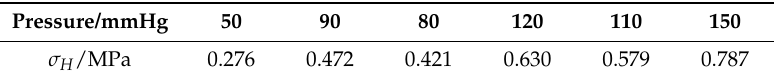
Table 1. (cid:2026) (cid:3009) of PET graft under each inner pressure. Table 1. σ H of PET graft under each inner pressure.